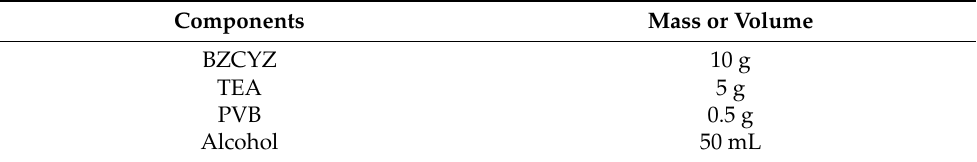
Table 3. Composition of electrolyte dip-coating slurry.